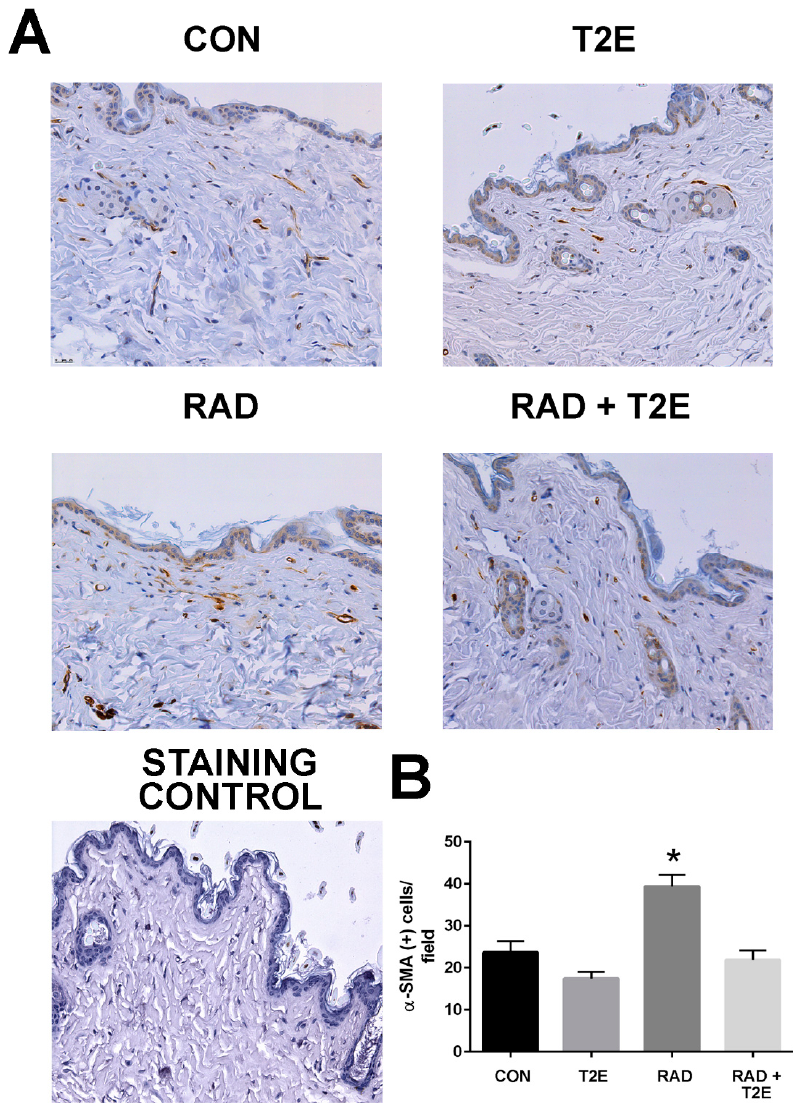
Figure 5. MnTE-2-PyP treatment blocks radiation-mediated upregulation of α -SMA positive cells in skin tissues. Skin sections were obtained from mice treated with +/ − MnTE-2-PyP and +/ − radiation, at 2 months post-radiation. ( A ). Skin sections were immunostained for α -SMA. Staining control includes entire staining procedure but omits primary antibody. ( B ). The average number of α -SMA positive cells per field for each group. A 1-way ANOVA followed by post hoc Tukey’s test for multiple comparisons was used to determine differences between groups. The symbol (*) denotes a significant difference as compared to the control group. Magnification bar = 25 µ m. There were 9–10